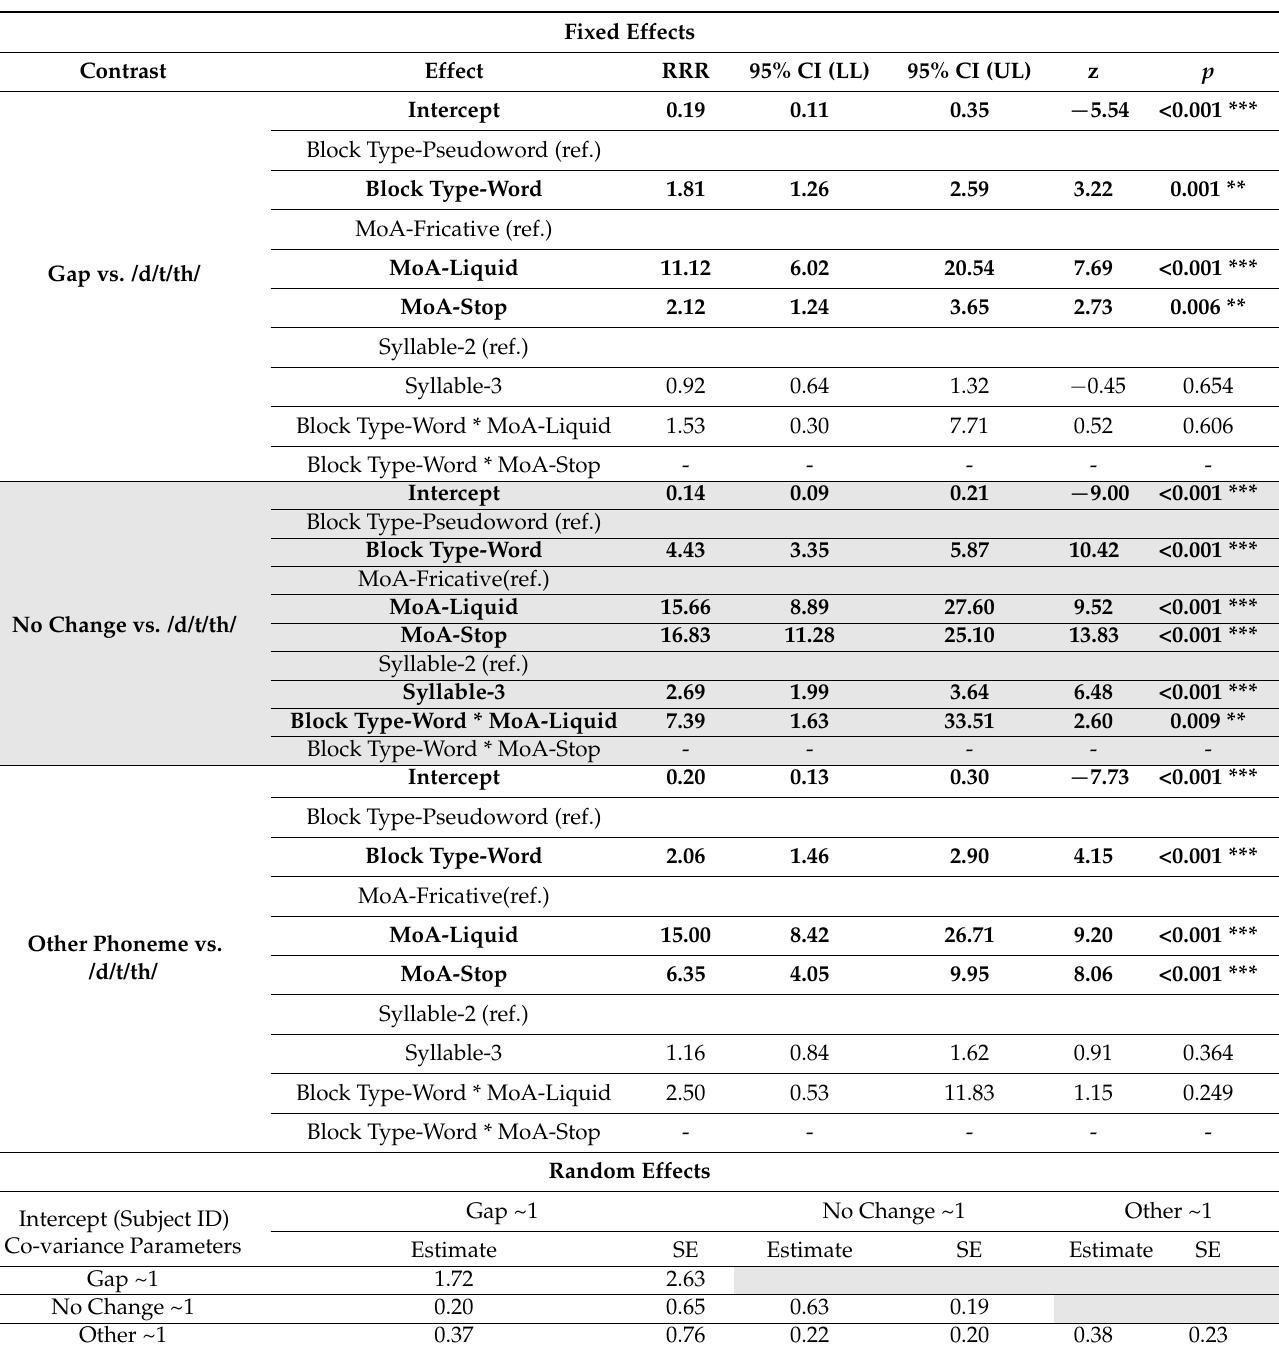
Table 2. Results of the Multinomial Logistic Regression to examine the interaction between Block Type and Manner of Articulation on auditory perception (while controlling for the effect of Syllable). Significant fixed effects/interactions are depicted in bold font and indicated with asterisks as follows: ** p < 0.01, *** p <